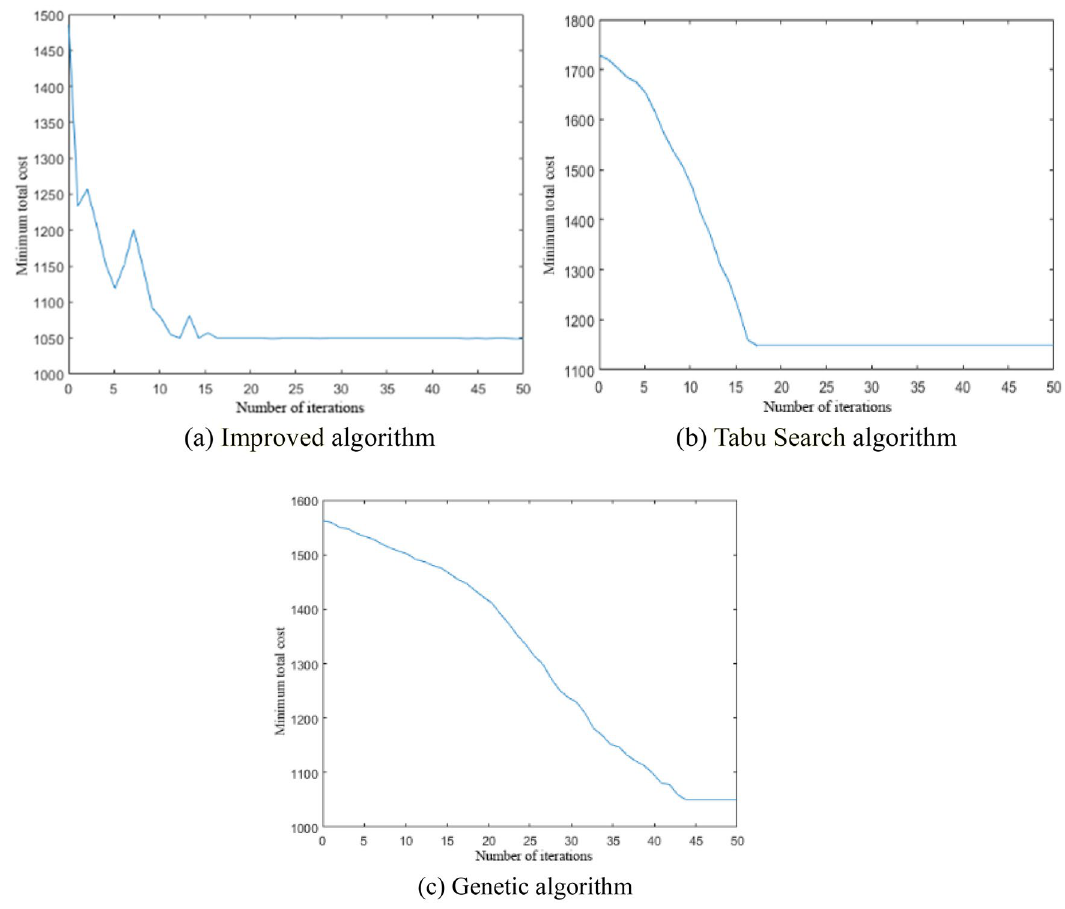
Figure 6. Convergence diagram of three algorithm.